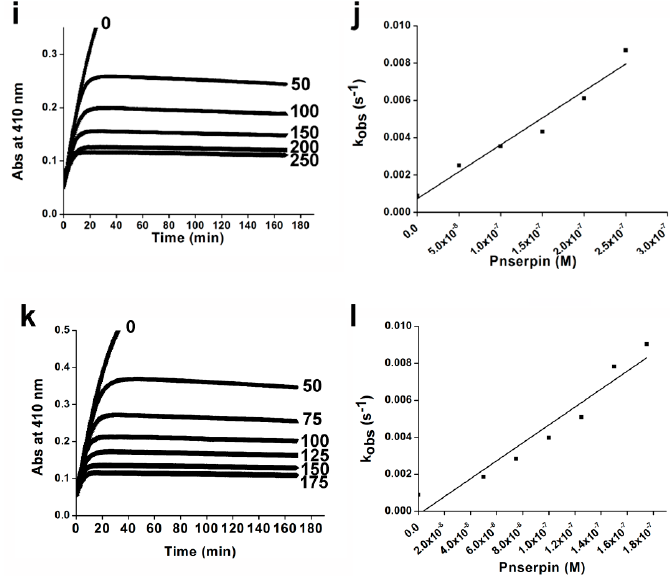
Figure 4. Progress curve analysis of protease inhibition by Pnserpin. ( a , c , e , g , i ) Progress curves for inhibition of CHT, SUC, elastase, PRK, and PnCHT by Pnserpin at 40 °C, respectively; ( k ) Progress curve for inhibition of PnCHT at 80 °C; ( b , d , f , h , j ) Plots of the k obs values of CHT, SUC, elastase, PRK, and PnCHT as a function of Pnserpin concentration at 40 °C, respectively; ( l ) Plot of the k obs values of PnCHT as a function of Pnserpin concentration at 80 °C. The number associated with each progress curve represents the concentration of Pnserpin (nM).